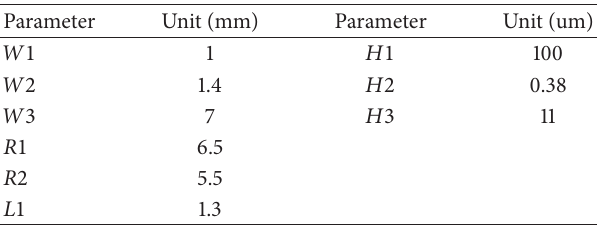
Table 1: Parameters of the proposed antenna.